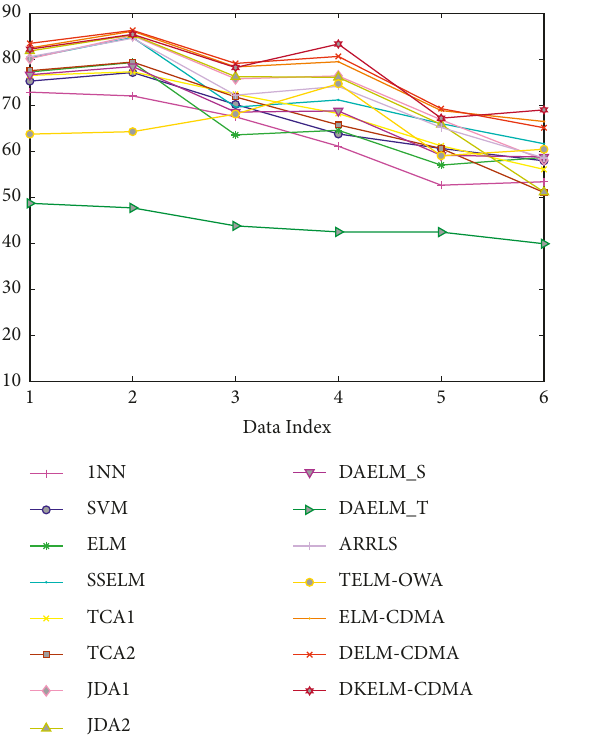
Figure 9: Classification accuracy of different algorithms on reu- ters-21578 data set.